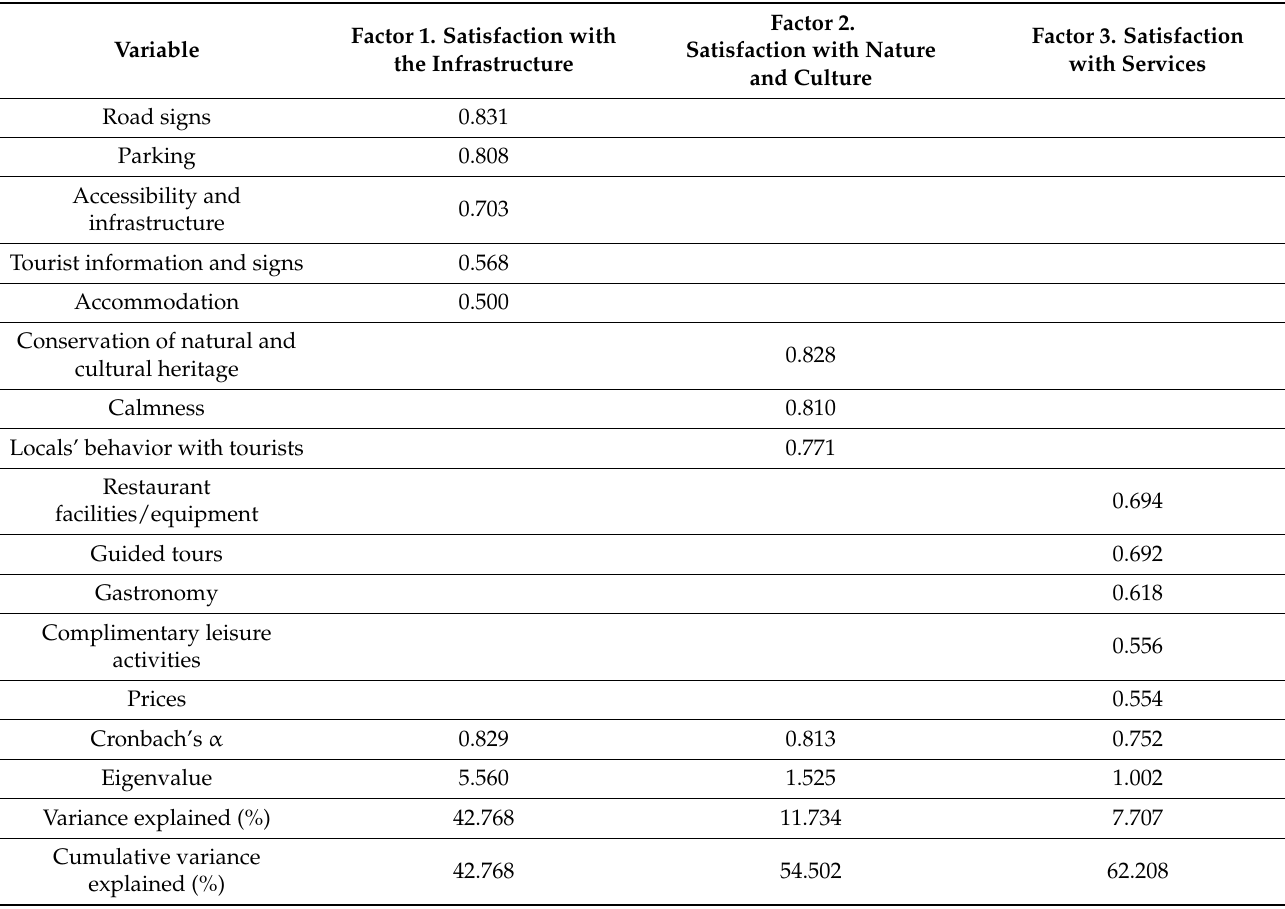
Table 1. Factor analysis of service